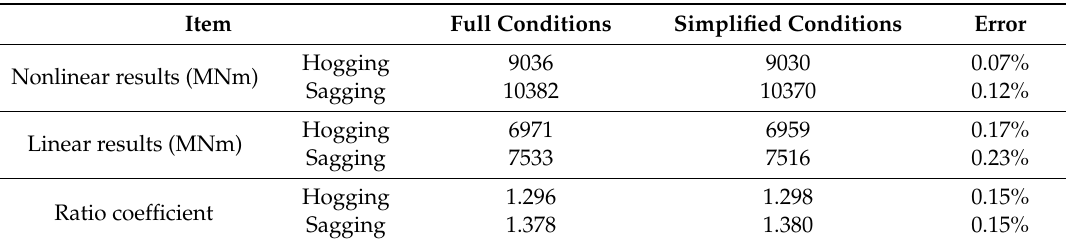
Figure 20. Long-term prediction results of VBM amidships. Table 4. Extreme of VBM amidships at probability level 10 − 8